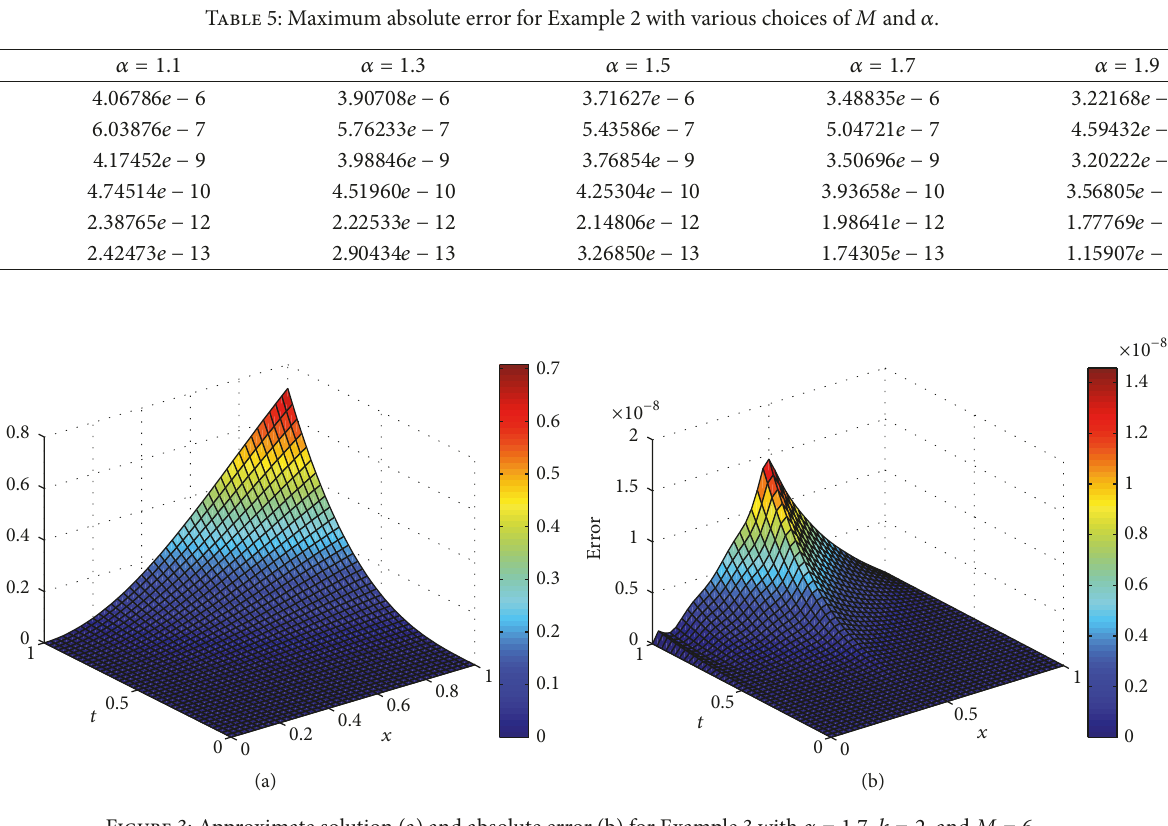
Figure 3: Approximate solution (a) and absolute error (b) for Example 3 with 𝛼 = 1.7 , 𝑘 = 2 , and 𝑀 = 6 .